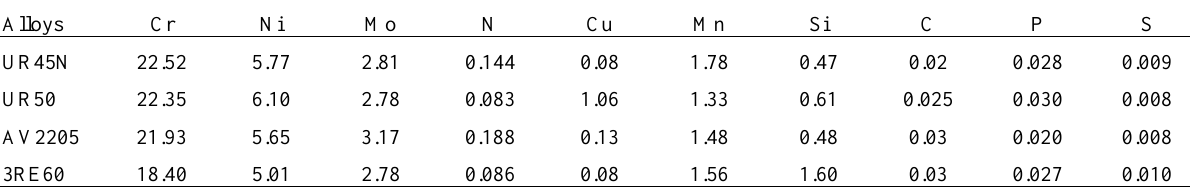
Table 1. Chemical composition of investigated alloys (in wt.%). Alloys Cr Ni Mo N Cu Mn Si